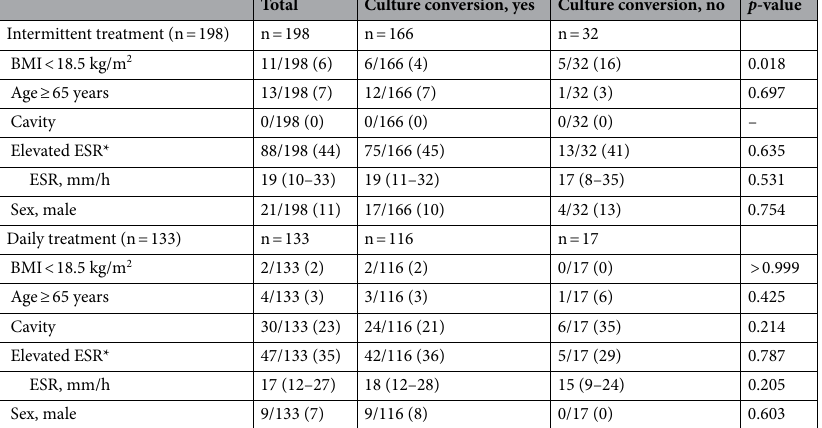
Total Culture conversion, yes Culture conversion, no p